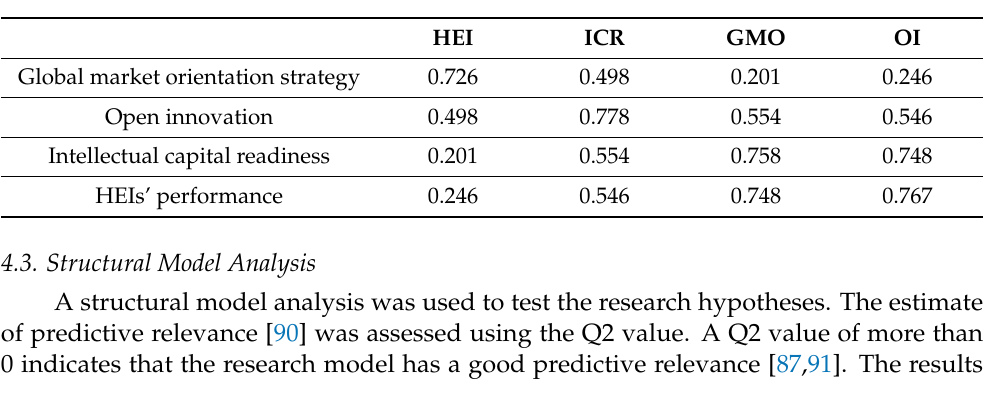
Table 5. Results of discriminant validity